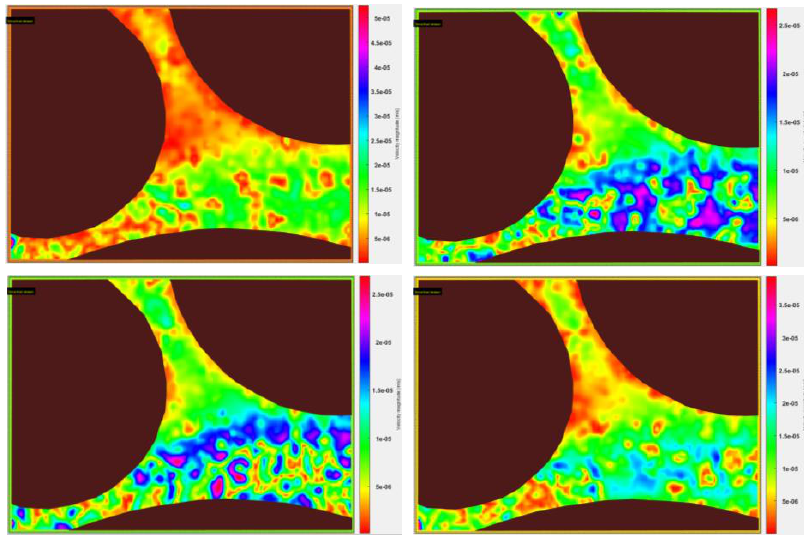
Figure 16. Velocimetry analysis for the flow of a 2000 ppm hydrolyzed polyacrylamide (HPAM) at 1 µL/min flow rate in a porous-media-resembling micromodel performed with PIVlab in MATLAB™. The input images for each velocimetry image were taken with 134 ms time difference.